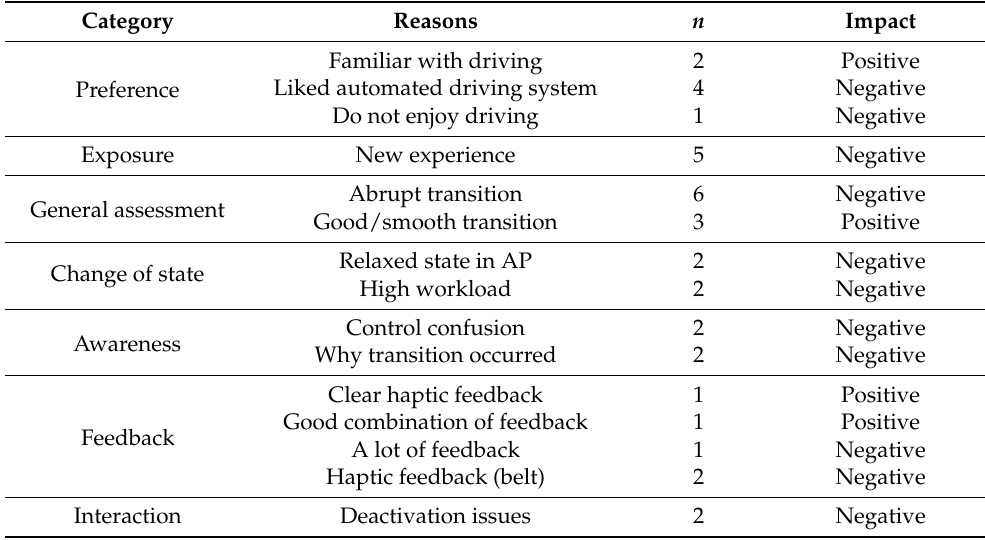
Table 2. Reasons influencing the experience of the transition. n = number of participants mentioning the